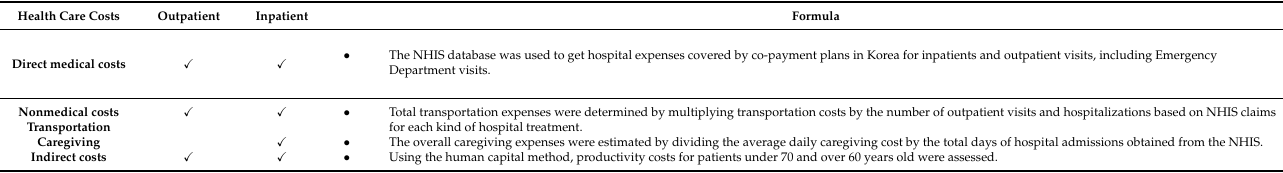
Table 4. Methods used to determine health care